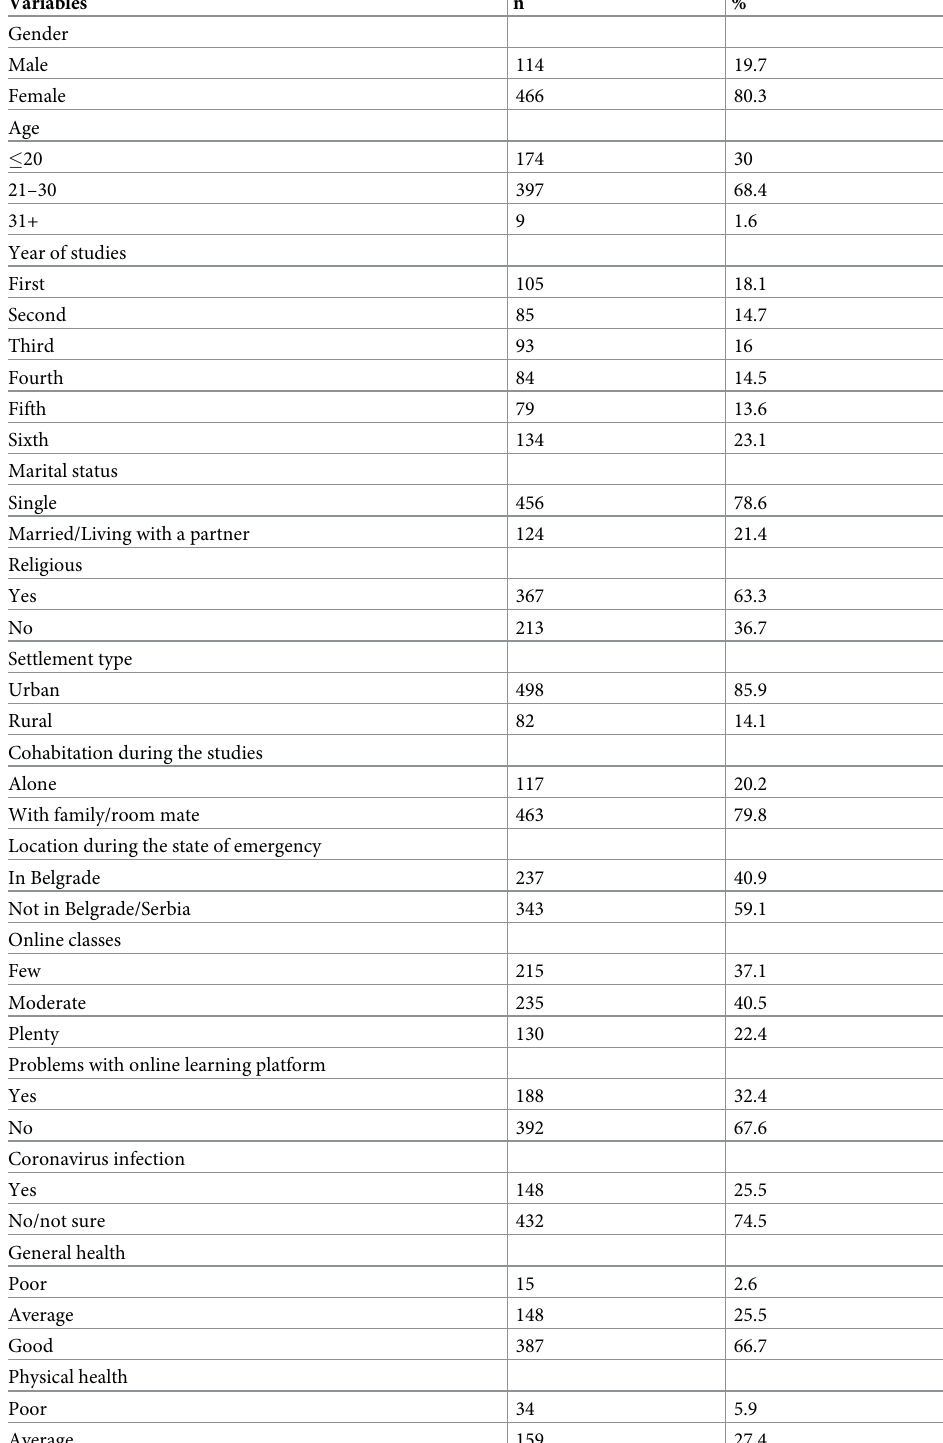
Table 1. Distribution of demographic variables, variables related to students medical studies and health status during the coronavirus epidemic, as well as, scales of depression, anxiety and